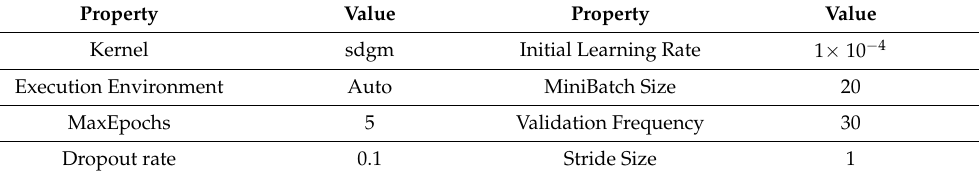
Table 3. Model training parameters for transfer learning of DenseNet201 and DarkNet53 models.